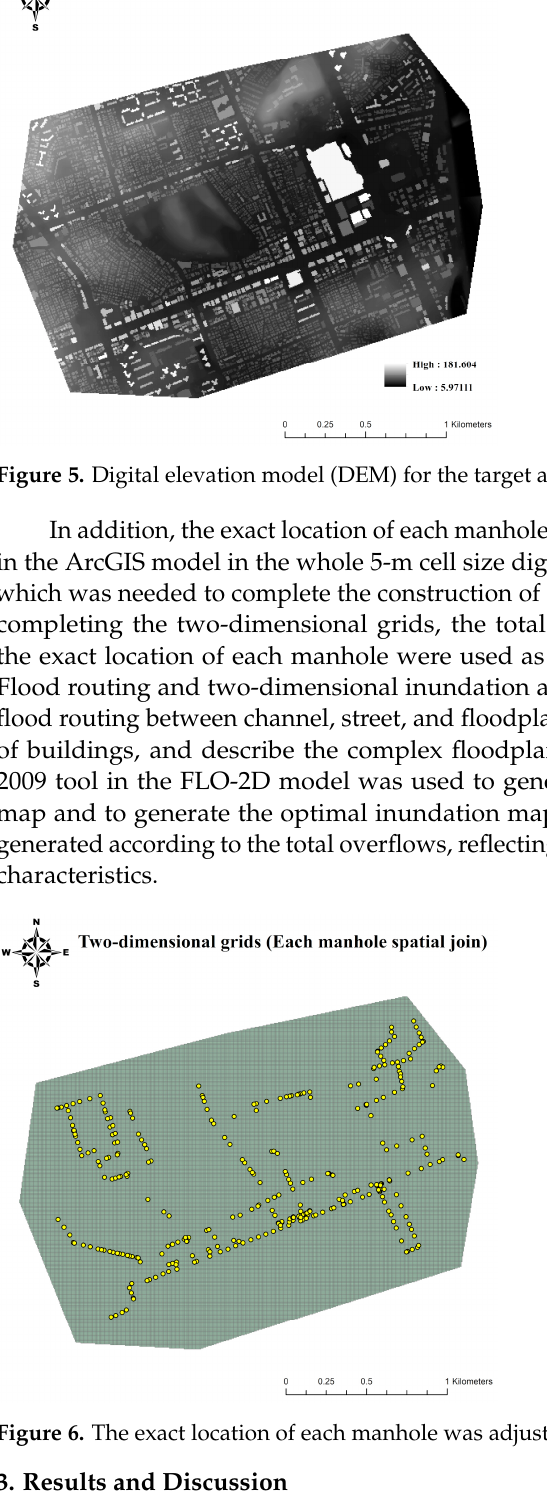
Figure 4. Flowchart of study methodology.